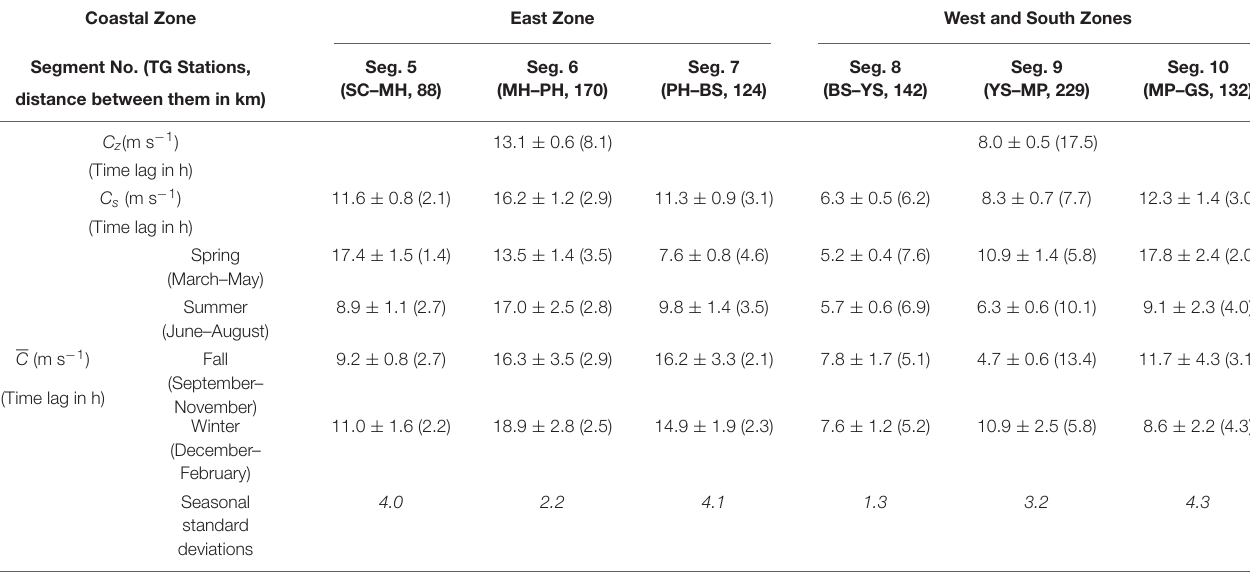
TABLE 1 | C z and C s of the observed propagation speeds (OPS, m s − 1 ) in two coastal zones (East Zone, West and South zones collectively), for six segments (Segs. 5–10), and the (cid:83) C of the OPS for four seasons (spring, summer, fall, and winter) and six segments. Coastal Zone East Zone West and South Zones Segment No. (TG